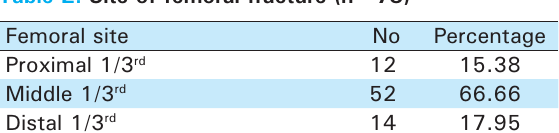
Table 2. Site of femoral fracture (n=78)